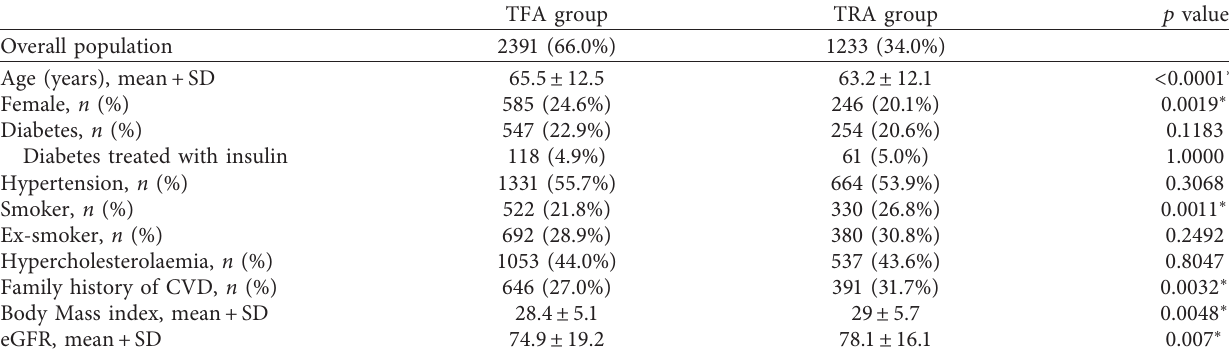
Table 1: Patient